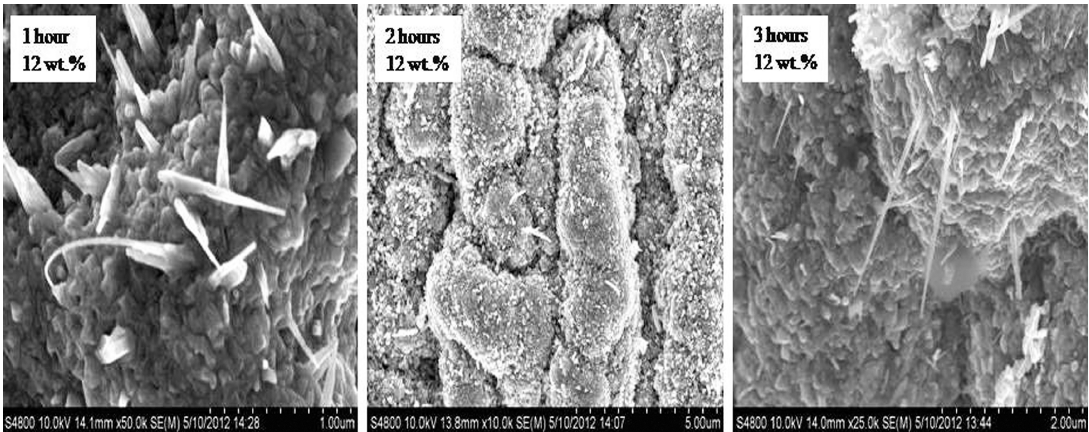
-12 wt.% O for 1. 2 and 3 2 2